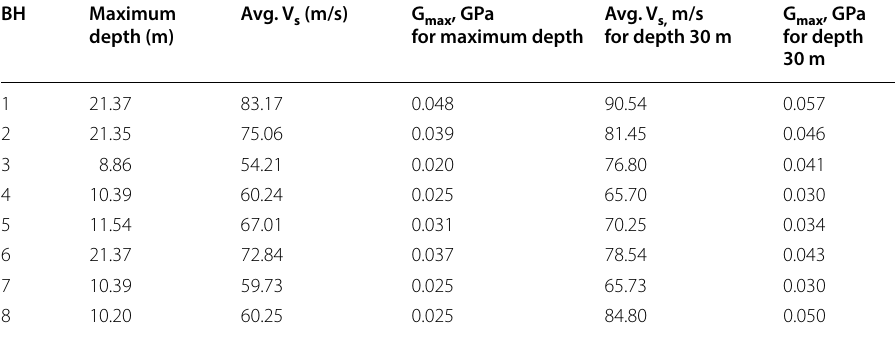
Table 6 Results obtained from MASW testing BH Maximum depth